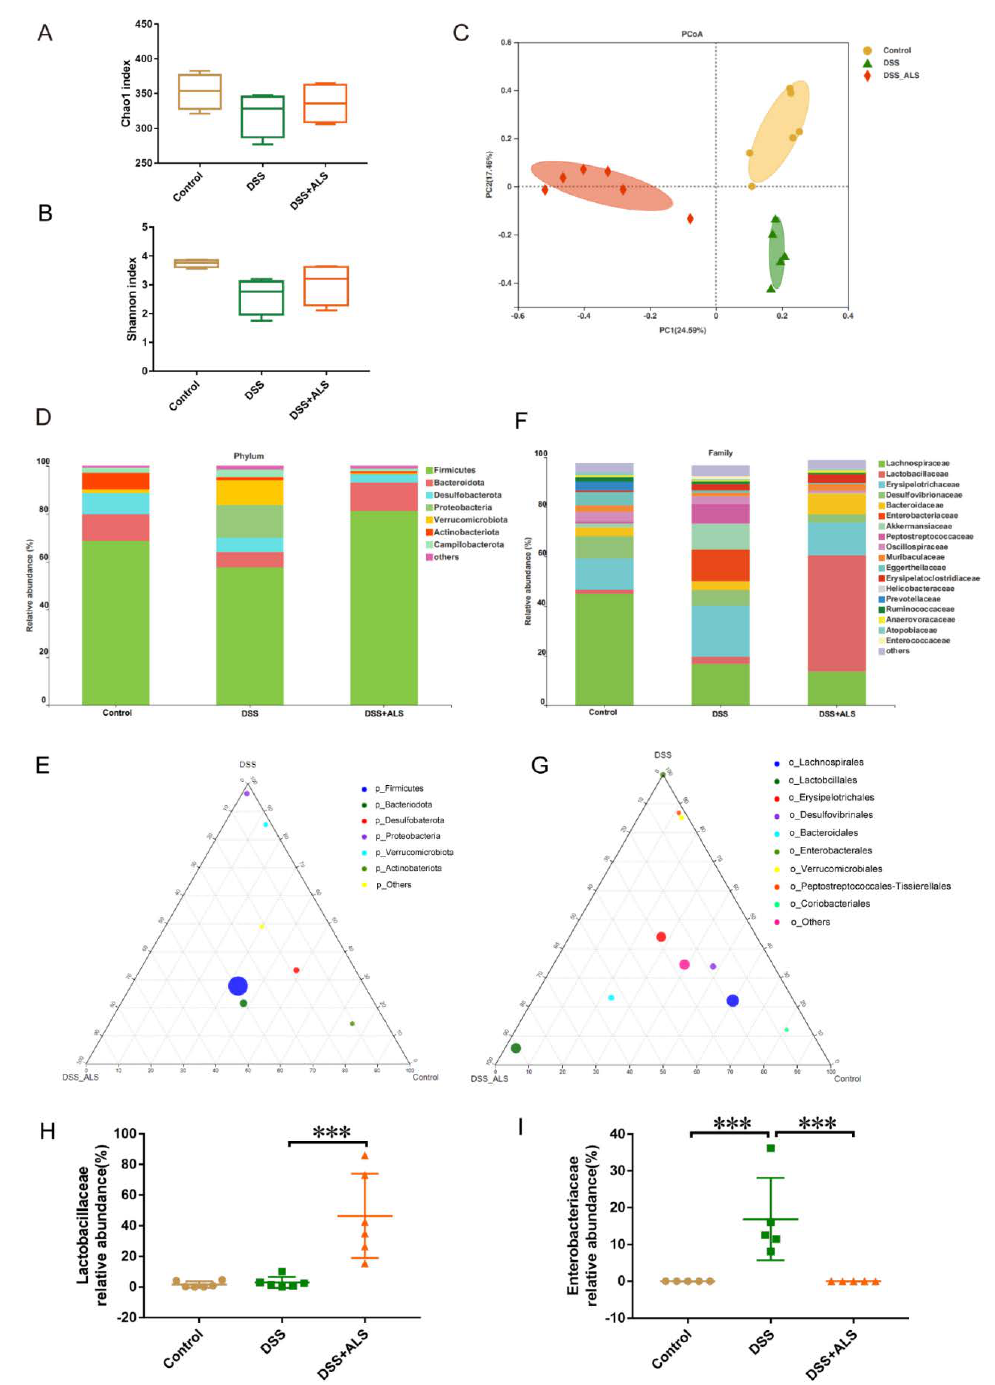
Figure 5. ALS ameliorates gut microbiota dysbiosis in cecum contents. ( A , B ) Estimation of gut bacterial richness (Chao1 index) and diversity (Shannon index). ( C ) PCoA plot illustrating gut microbiota composition. ( D ) Phylum level of relative abundance of bacterial species in the cecum content of mice. ( E ) Phylum-level taxonomy illustrated by Ternary plot graph. The relative abundance of the bacteria indicated by the distance between vertex and each circle. ( F ) Family level of relative abundance of bacterial species in the cecum content of mice. ( G ) Family-level taxonomy illustrated by Ternary plot graph. ( H ) Relative abundance of Lactobacillaceae in the cecum content. ( I ) Relative abundance of Enterobateriaceae in the cecum content. Data are mean ± SEM. n = 5–6 mice per group. *** p < 0.001.